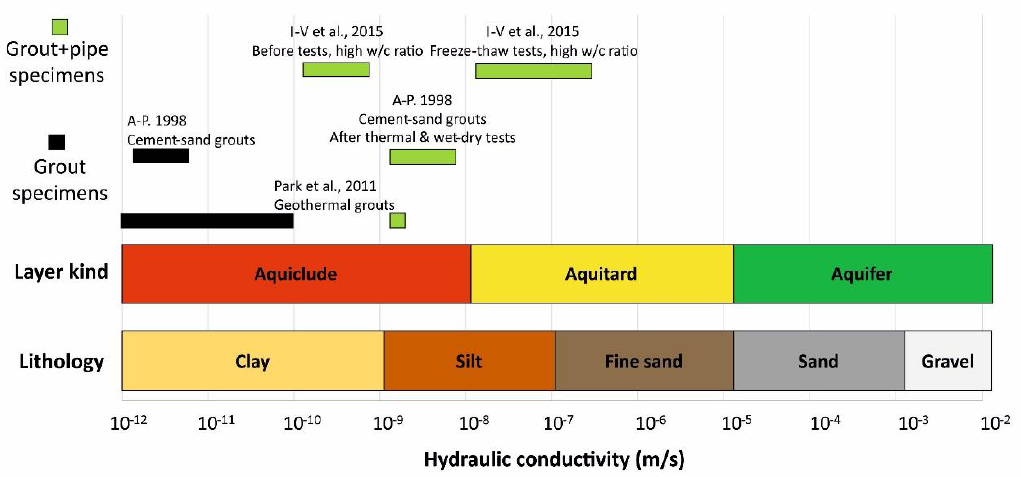
Figure 1. Hydraulic conductivity ranges of geothermal grouts from laboratory tests and of typical aquifer, aquitard and aquiclude lithologies. Source: Casasso and Sethi [10].